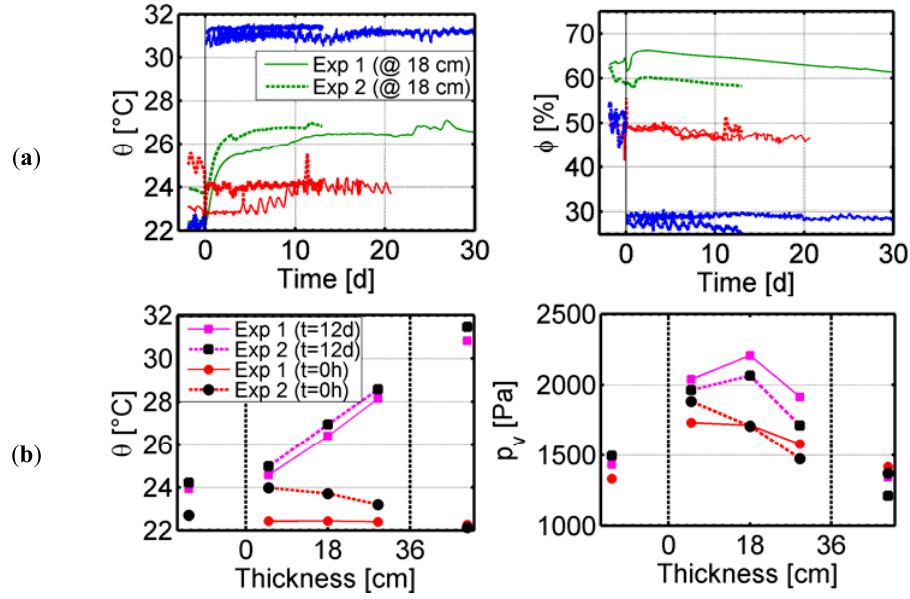
Figure 7. Repeatability of the Experiment 1: ( a ) time response in θ and ϕ at x = 18 cm; and ( b ) spatial response in θ and p at t = 0 and 12 d of uncoated hemp concrete wall subjected v to temperature and relative humidity gradient. (Solid lines refer to the first experiment, dashed line to the second